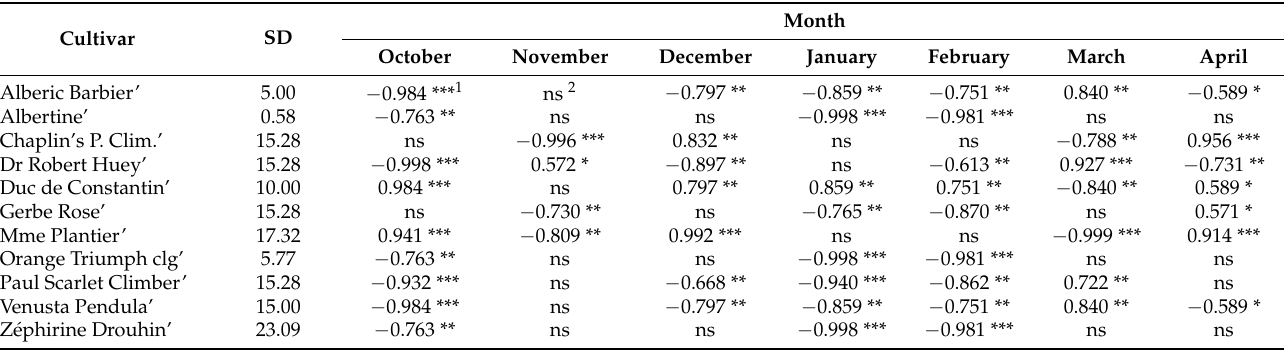
Table 7. The effect of correlations between average monthly air temperature (2005/2006, 2009/2010, and 2015/2016) and the term of bud break with visible first leaf tips (BBCH 07) in climber roses. Cultivar